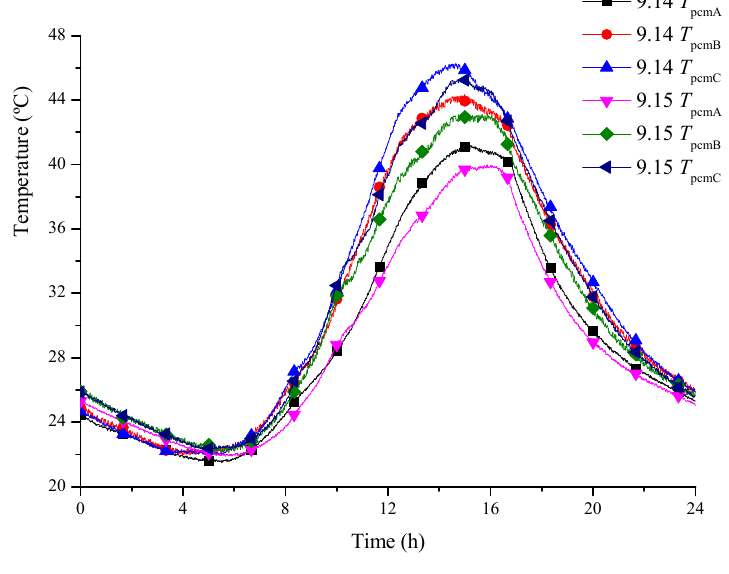
Figure 10. Temperature comparison of PCM plate. Table 3. Main data of temperature comparison of the PCM plate.